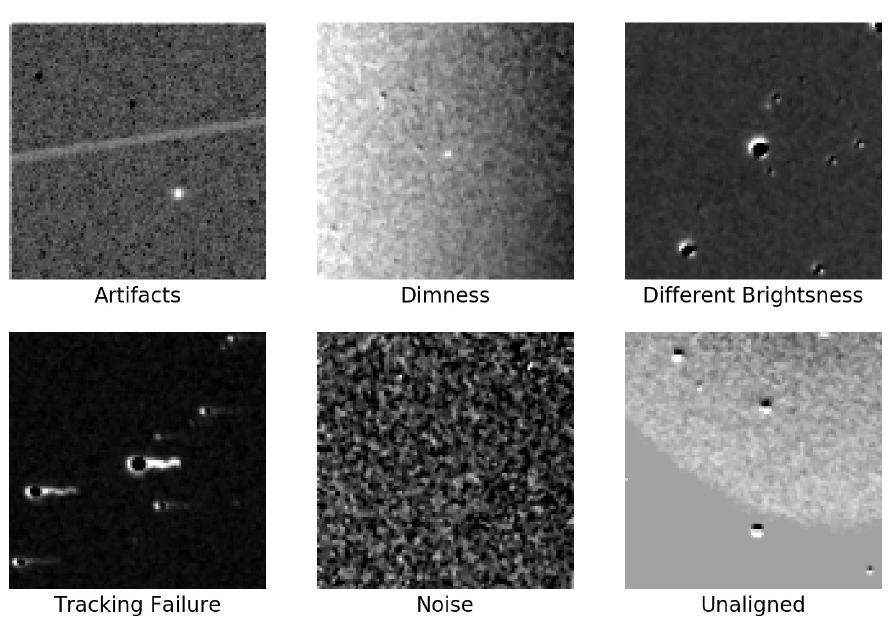
Figure 2. Defections in the PSP-SN dataset.